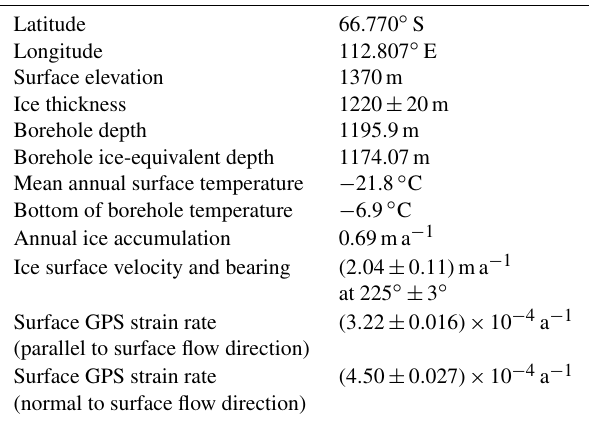
Table 1. DSS borehole site and ice core information (Morgan et al., 1997,